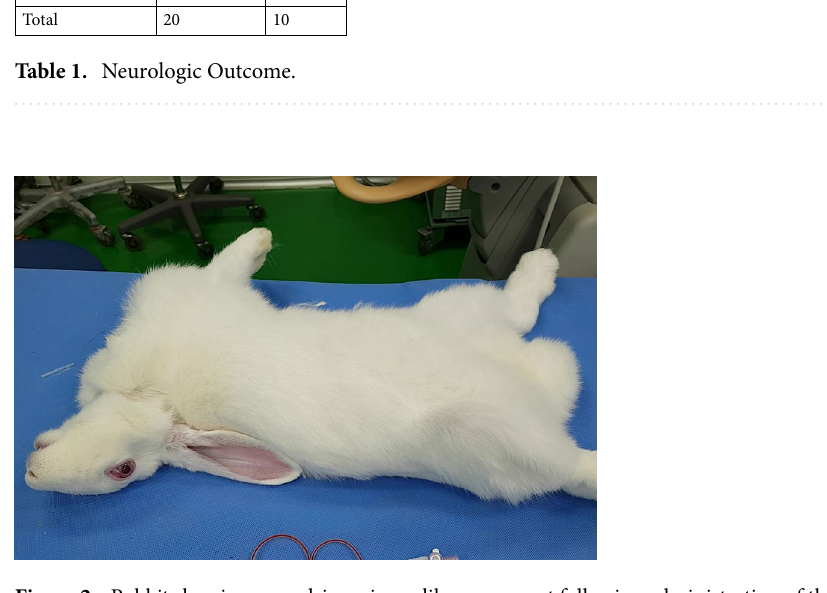
Figure 2. Rabbit showing convulsive seizure-like movement following administration of the embolic